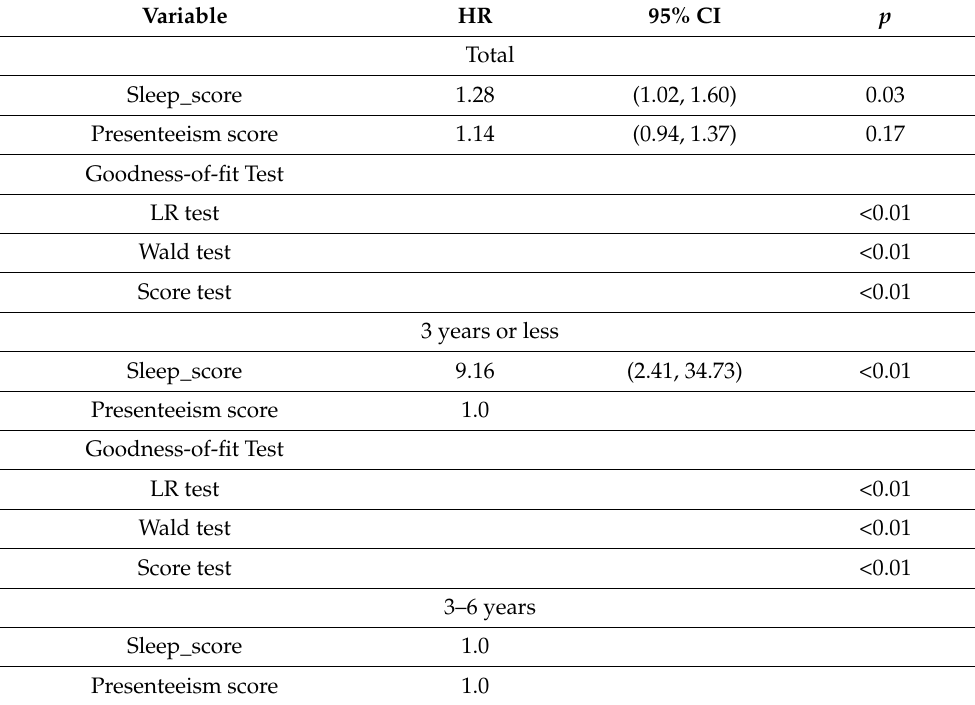
Table 2. Results of the time-independent Cox proportional hazard regression.